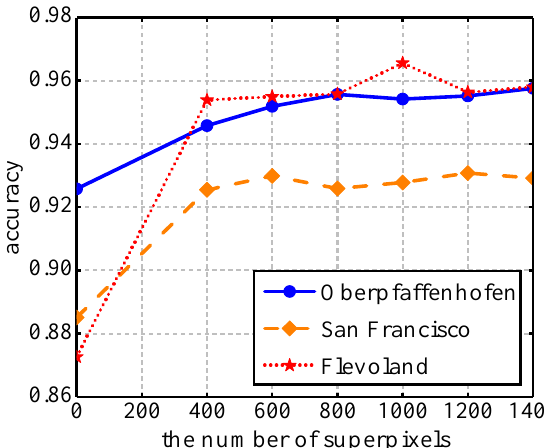
Figure 18. Accuracy curve of Flevoland, San Francisco and Oberpafaffenhofen data sets under different numbers of